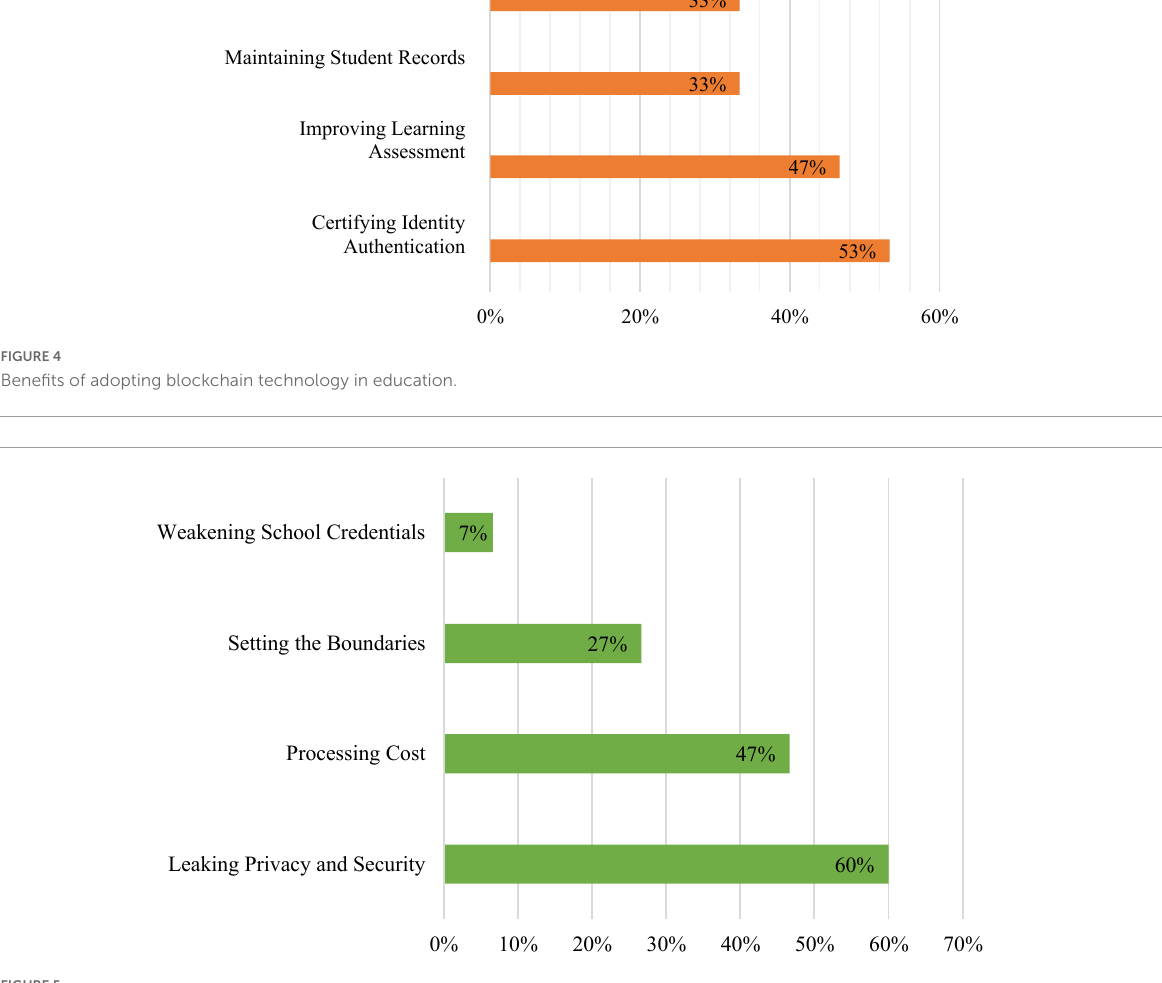
FIGURE5 Challenges of adopting blockchain technology in